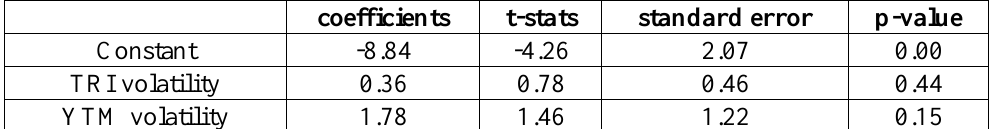
Table 5. Quantile Regression Results for Value at Risk of Aseman Yekom Mutual Fund in